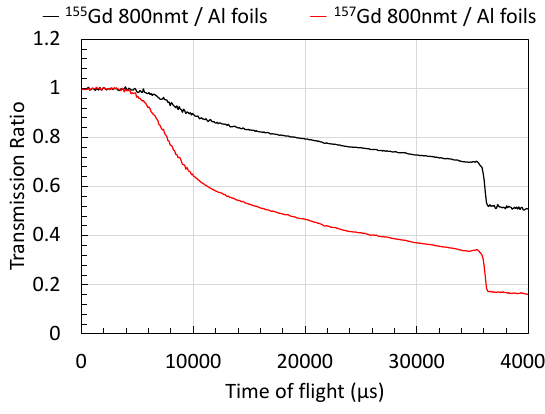
Figure 6. Transmission ratios of the 155 Gd and 157 Gd samples to the Al